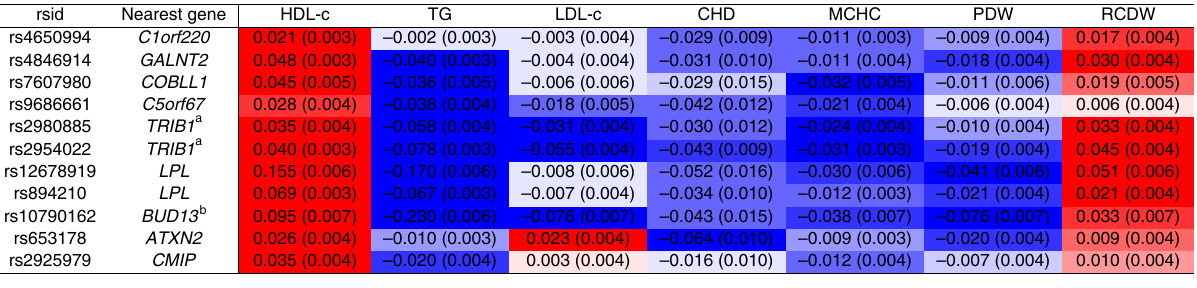
Fig. 3 Variants having same directions of associations with blood cell traits. Details of genetic variants, nearest gene, beta-coef fi cients (standard errors, SE) for associations with HDL-cholesterol (HDL-c), triglycerides (TG), LDL-cholesterol (LDL-c), coronary heart disease (CHD) risk, mean corpuscular haemoglobin concentration (MCHC), platelet distribution width (PDW), and red cell distribution width (RCDW) for 11 genetic variants in 9 distinct gene regions having a distinct pattern of associations. All associations are orientated to the HDL-cholesterol increasing allele. Red indicates that the association is positive; blue for negative. The brightness of the colouring corresponds to the p -value for the strength of association from a Z -test; brighter colours correspond to lower p